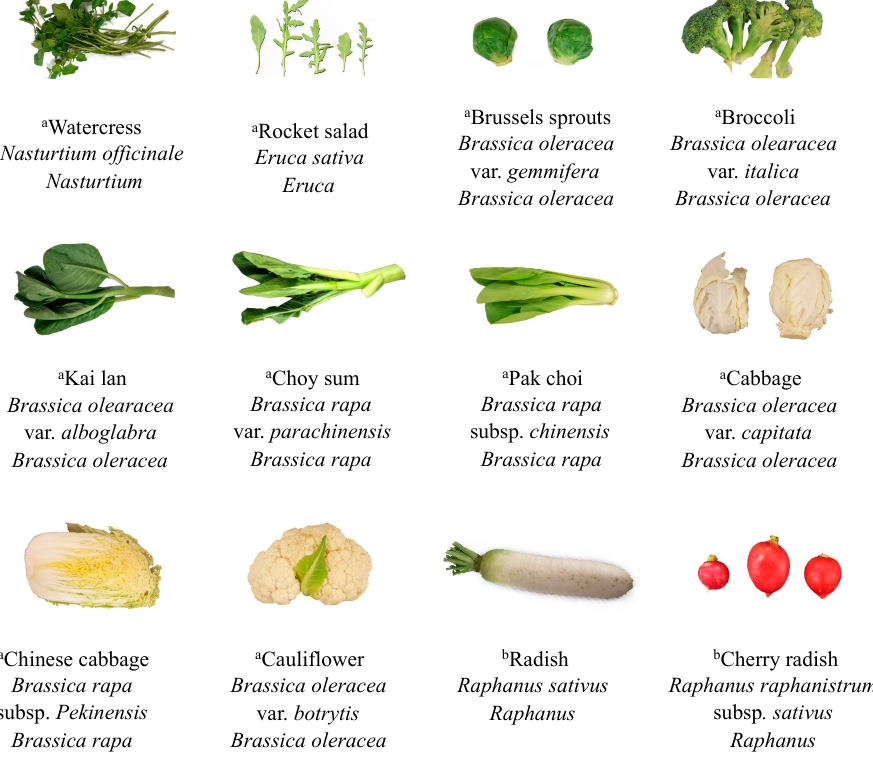
Figure 6. Information (common name, Latin name and species) of the 12 Brassicaceae vegetables ( a vegetables grown above-ground; b vegetables grown below-ground).